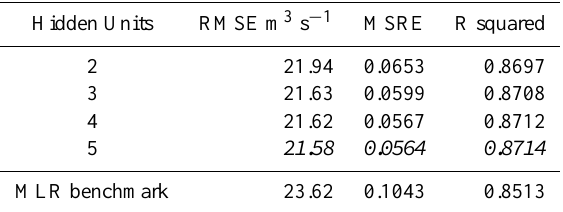
Table 5. Calibration performance of candidate models for Scenario B. Best performing ANN models for each metric are in italic.